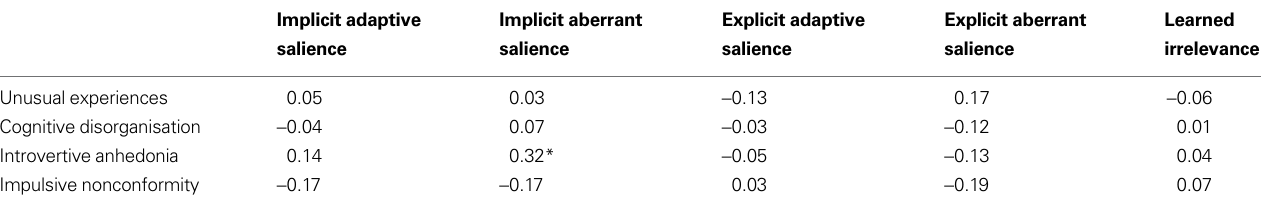
Table 4 | Correlations between the salience and learned irrelevance variables, and schizotypy subscales. Implicit